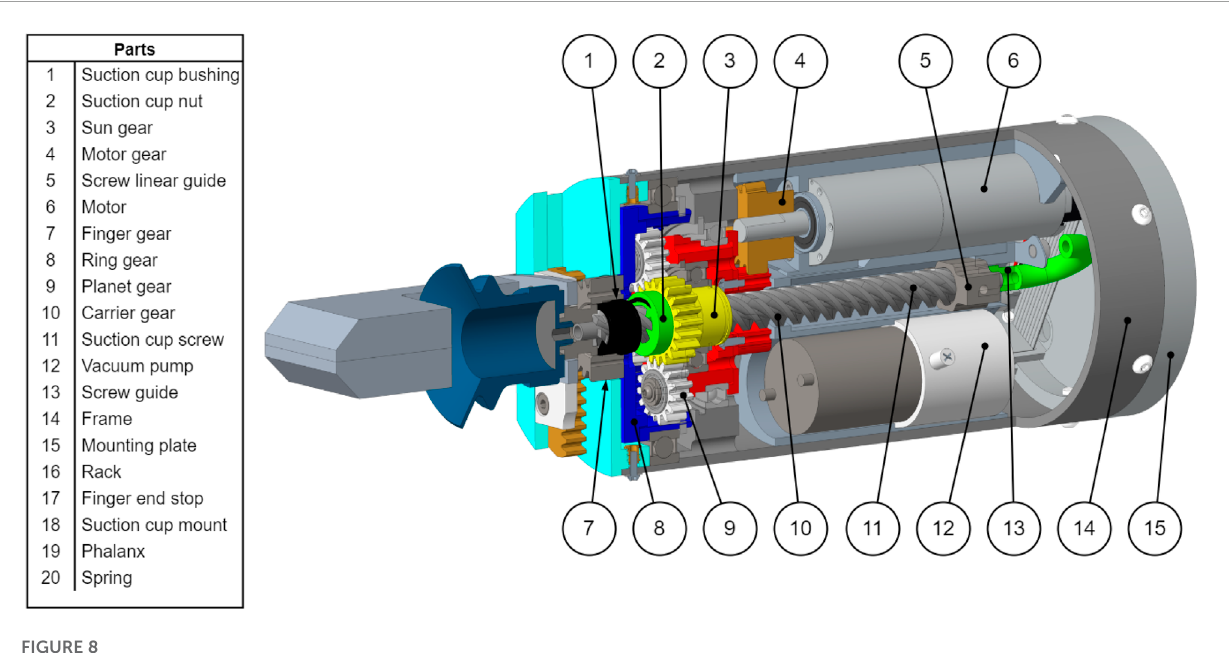
FIGURE 8 Design partial section